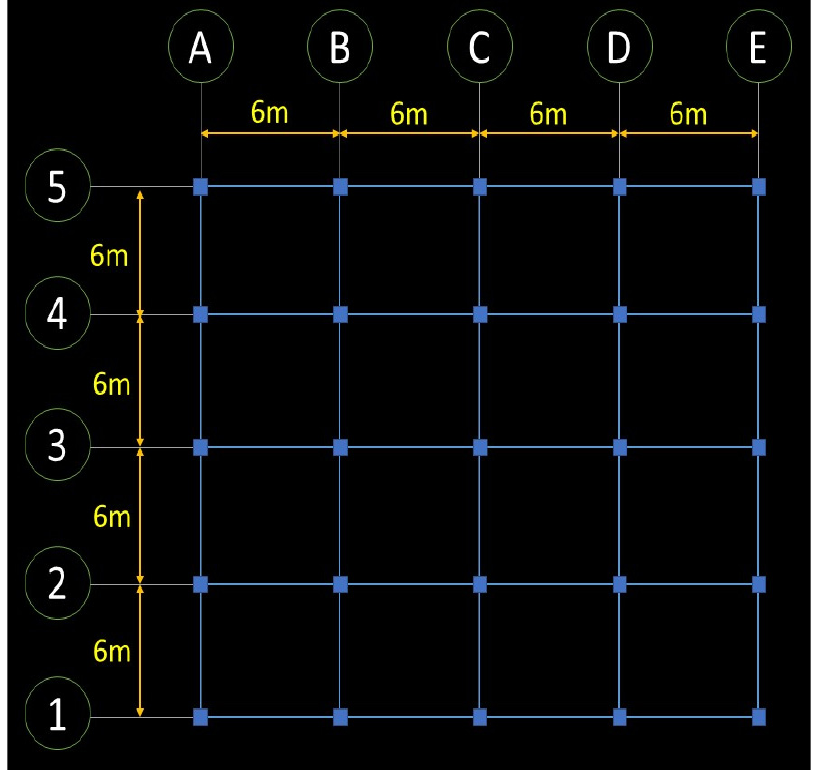
Figure 2. Typical floor framing plan [37].